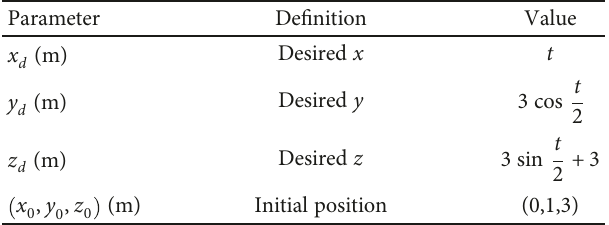
Table 1: Parameters using in